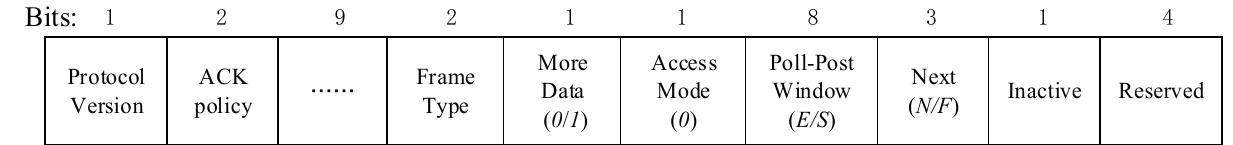
Figure 7. The fields of frame control format for polled allocation.